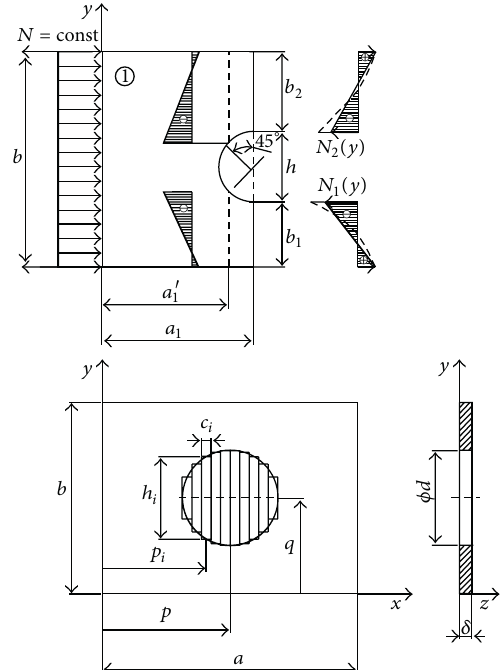
Figure 7: Distribution of the circular hole in rectangular gaps.